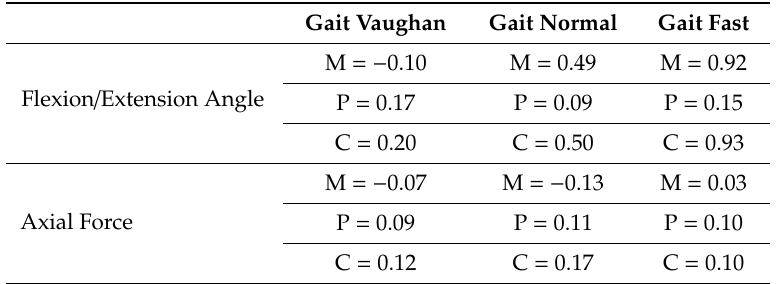
Table 3. Geers metric: in silico vs. ISO